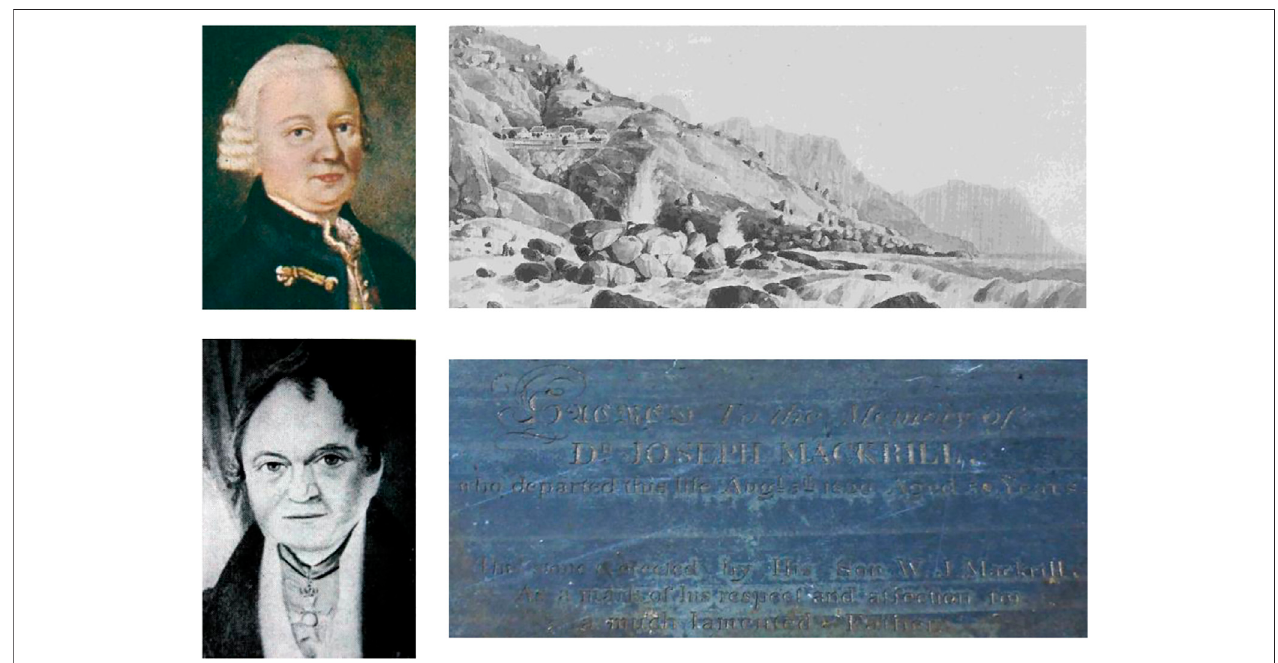
FIGURE3| FriedrichLudwigLiesching,Liesching ’ scottagesatBotanyBay(1832),BaronvonLudwig(~1840),JosephMackrill ’ sgravestoneatMaitlandcemetery, Cape Town.